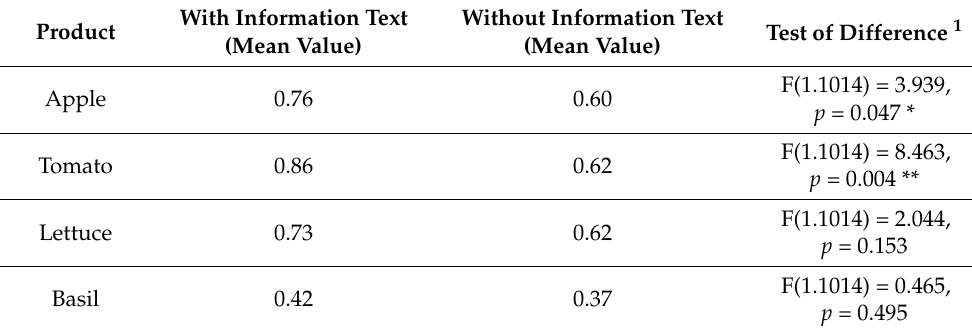
Table 2. Effect of explanatory information on consumer acceptance of iodine-biofortified fresh fruit and vegetables. n =